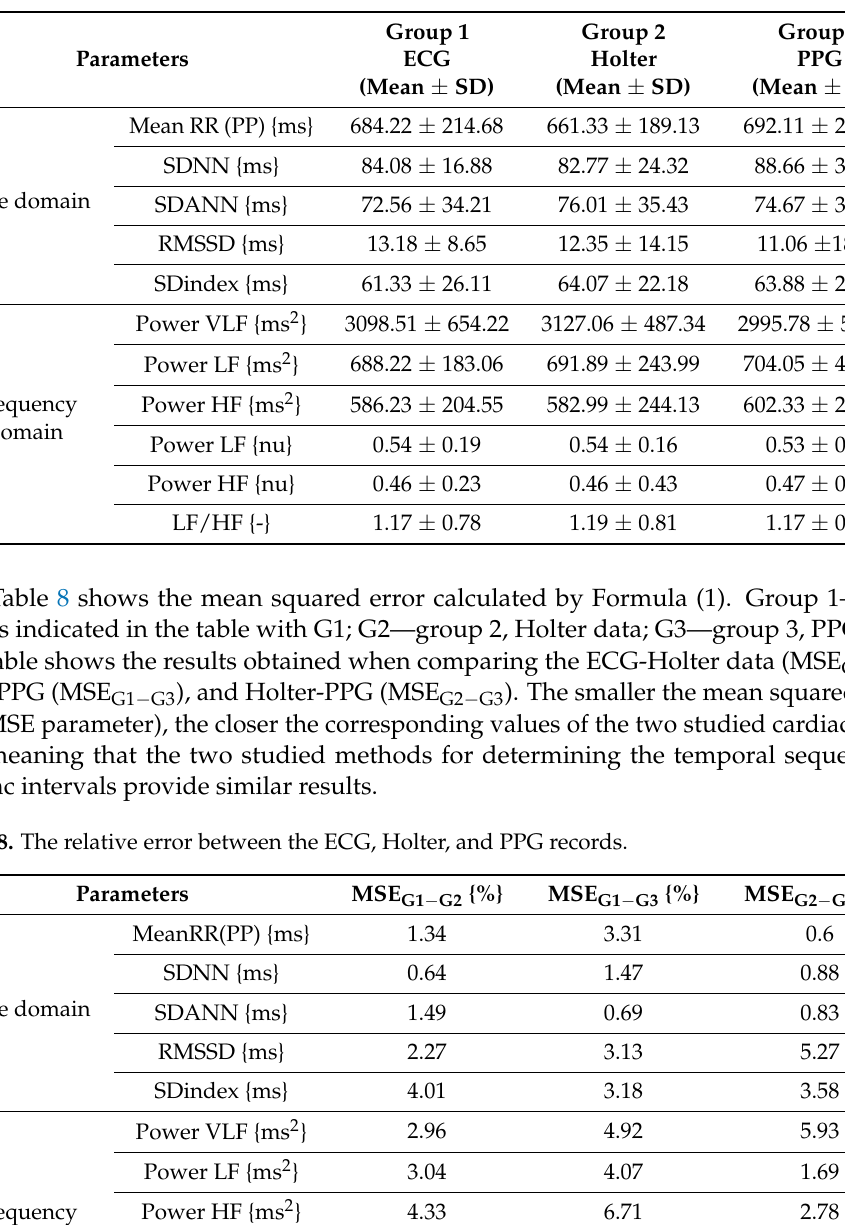
Table 7. HRV parameters for ECG, Holter, and PPG records.